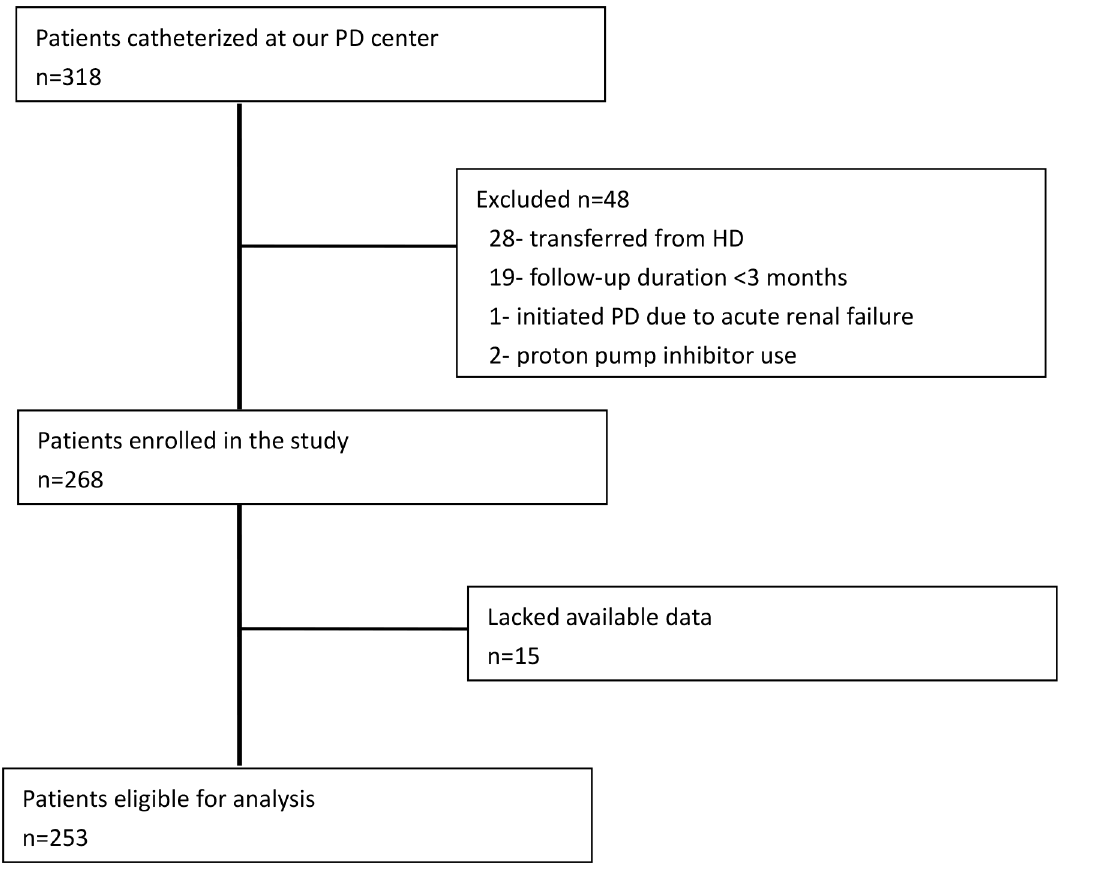
Fig 1. Patient selection